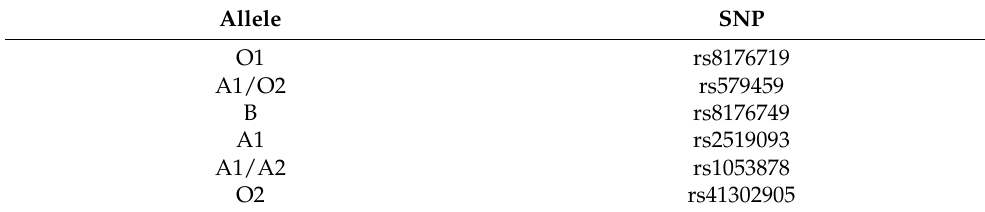
Table 1. List of the SNPs used to define the ABO genotype. Allele SNP O1 rs8176719 A1/O2 rs579459 B rs8176749 A1 rs2519093 A1/A2 rs1053878 O2